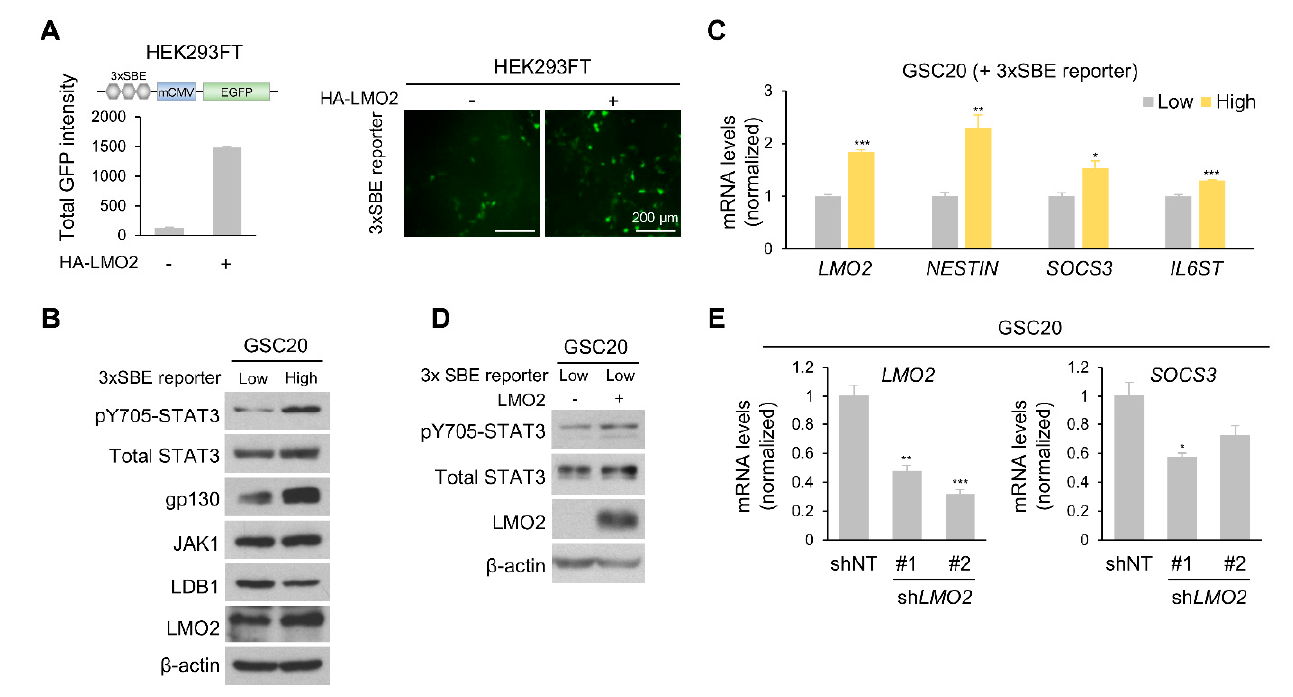
Figure 3. LMO2 and gp130 Are Key Factors for Activating STAT3 Signaling. ( A ) HEK293FT cells were transfected with the 3 × STAT3 binding element (SBE) reporter vector, together with an expression vector encoding control or LMO2 (left panel). Representative fluorescence images of 3 × SBE reporter system-induced U87MG cells transduced with either LMO2 or control expressing lentivirus (right panel). ( B ) Cell lysates of GSC20 cells (3 × SEB reporter-High and -Low) transduced with either control or LMO2-expressing lentiviruses were immunoblotted with antibodies specific for pY705-STAT3, total STAT3, gp130, JAK1, LDB1, LMO2, and β -actin. ( C ) The mRNA levels of the indicated genes in 3 × SBE reporter-High and -Low GSC20 cells were determined by real-time PCR. Data are expressed as mean ± SEM. The two-tailed Student’s t -test was used to analyze the statistical significance between each group ( n = 3 for each group). * p < 0.05, ** p < 0.01, *** p < 0.001. ( D ) Cell lysates of GSC20 cells (3 × SEB reporter-Low) transduced with either control or LMO2-expressing lentiviruses were immunoblotted with antibodies specific for pY705-STAT3, total STAT3, LMO2, and β -actin. ( E ) mRNA levels of the indicated genes in GSC20 cells transduced with either LMO2 shRNA- or non-target shRNA-expressing lentiviruses were determined by real-time PCR. Data are expressed as mean ± SEM. The two-tailed Student’s t -test was used to analyze the statistical significance between each group ( n = 3 for each group). * p < 0.05, ** p < 0.01, *** p < 0.001.